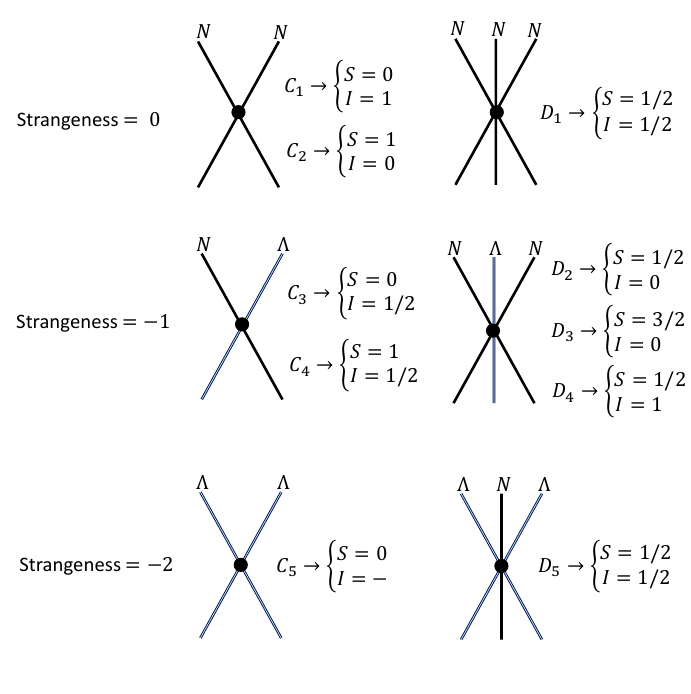
Figure 2. Diagrammatic representation of 2,3-baryon intearactions apearing at LO in single- and double- Λ BEFT. Here C i stand for the two-body LECs, and D j for the three-body LECs. S is the spin, and I the isospin. Figure taken from